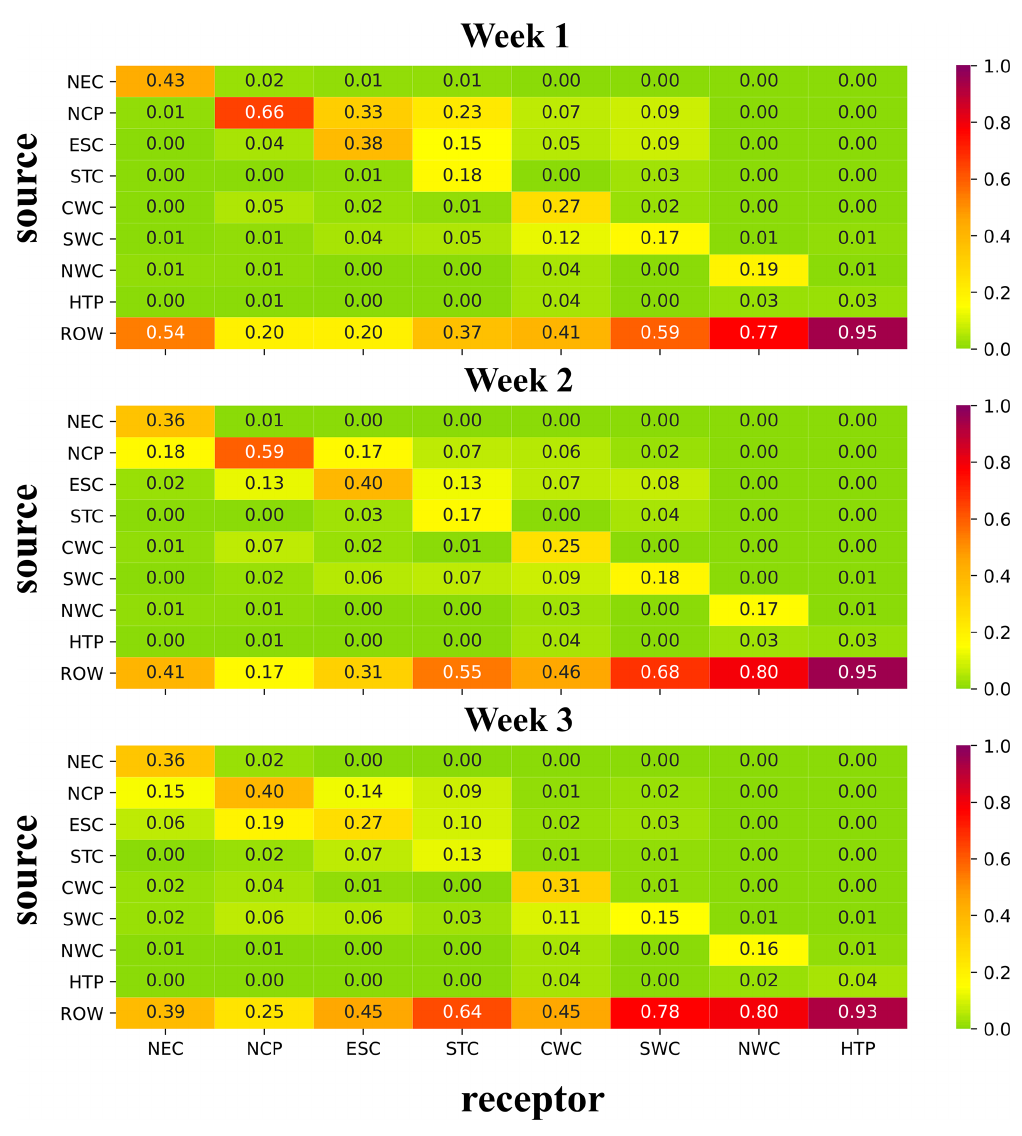
Table 1. Fractional contributions of emissions from nine tagged source regions (vertical axis) to mean PM 2 . 5 column burden in eight